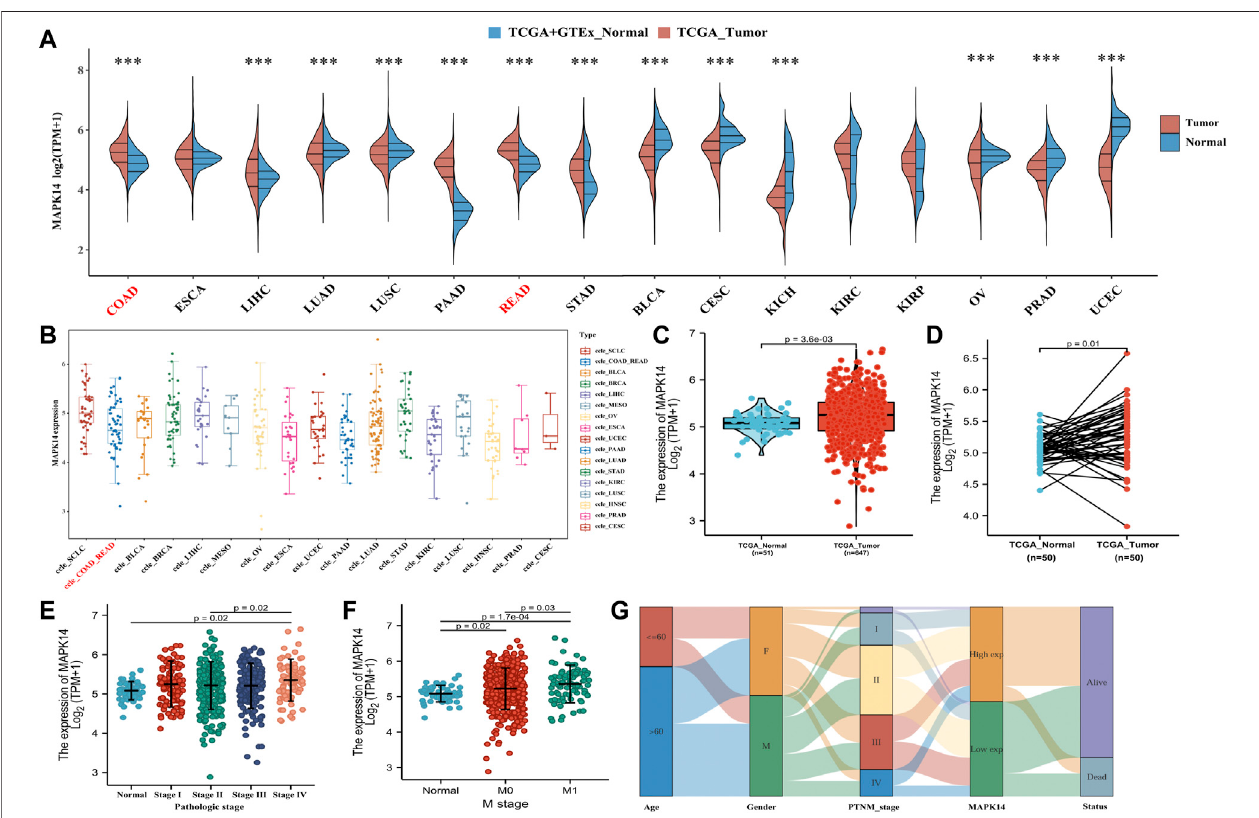
FIGURE 2 | Expression analysis of Mapk14 in multiple cancers and the relationship between clinical and pathological features of Mapk14. (A) Expression distribution of the Mapk14 gene in 16 human cancers was investigated based on TCGA cancer data and TCGA and GTEx normal data. The horizontal axis represents different tumor tissues, the vertical axis represents the expression distribution of this gene, and different colors represent different groups. The signi fi cance of the two groups of samples passed the Wilcoxon test. (B) Expression distribution of the Mapk14 gene in different tumor tissues. The horizontal axis represents different groups of samples, and the verticalaxis represents the Mapk14 gene expression distribution. (C – D) Comparison of Mapk14 expression between TCGA-CRC data and corresponding TCGA normal data. (E) Mapk14 expression in different pathological stages (stages I, II, III and IV) was analyzed based on the TCGA database. (F) Expression of Mapk14 in patients with different M-stages was analyzed based on TCGA data. (G) Mapk14 expression was associated with different clinical features according to Sankey plots. * p < 0.05, ** p < 0.01, and *** p < 0.001.